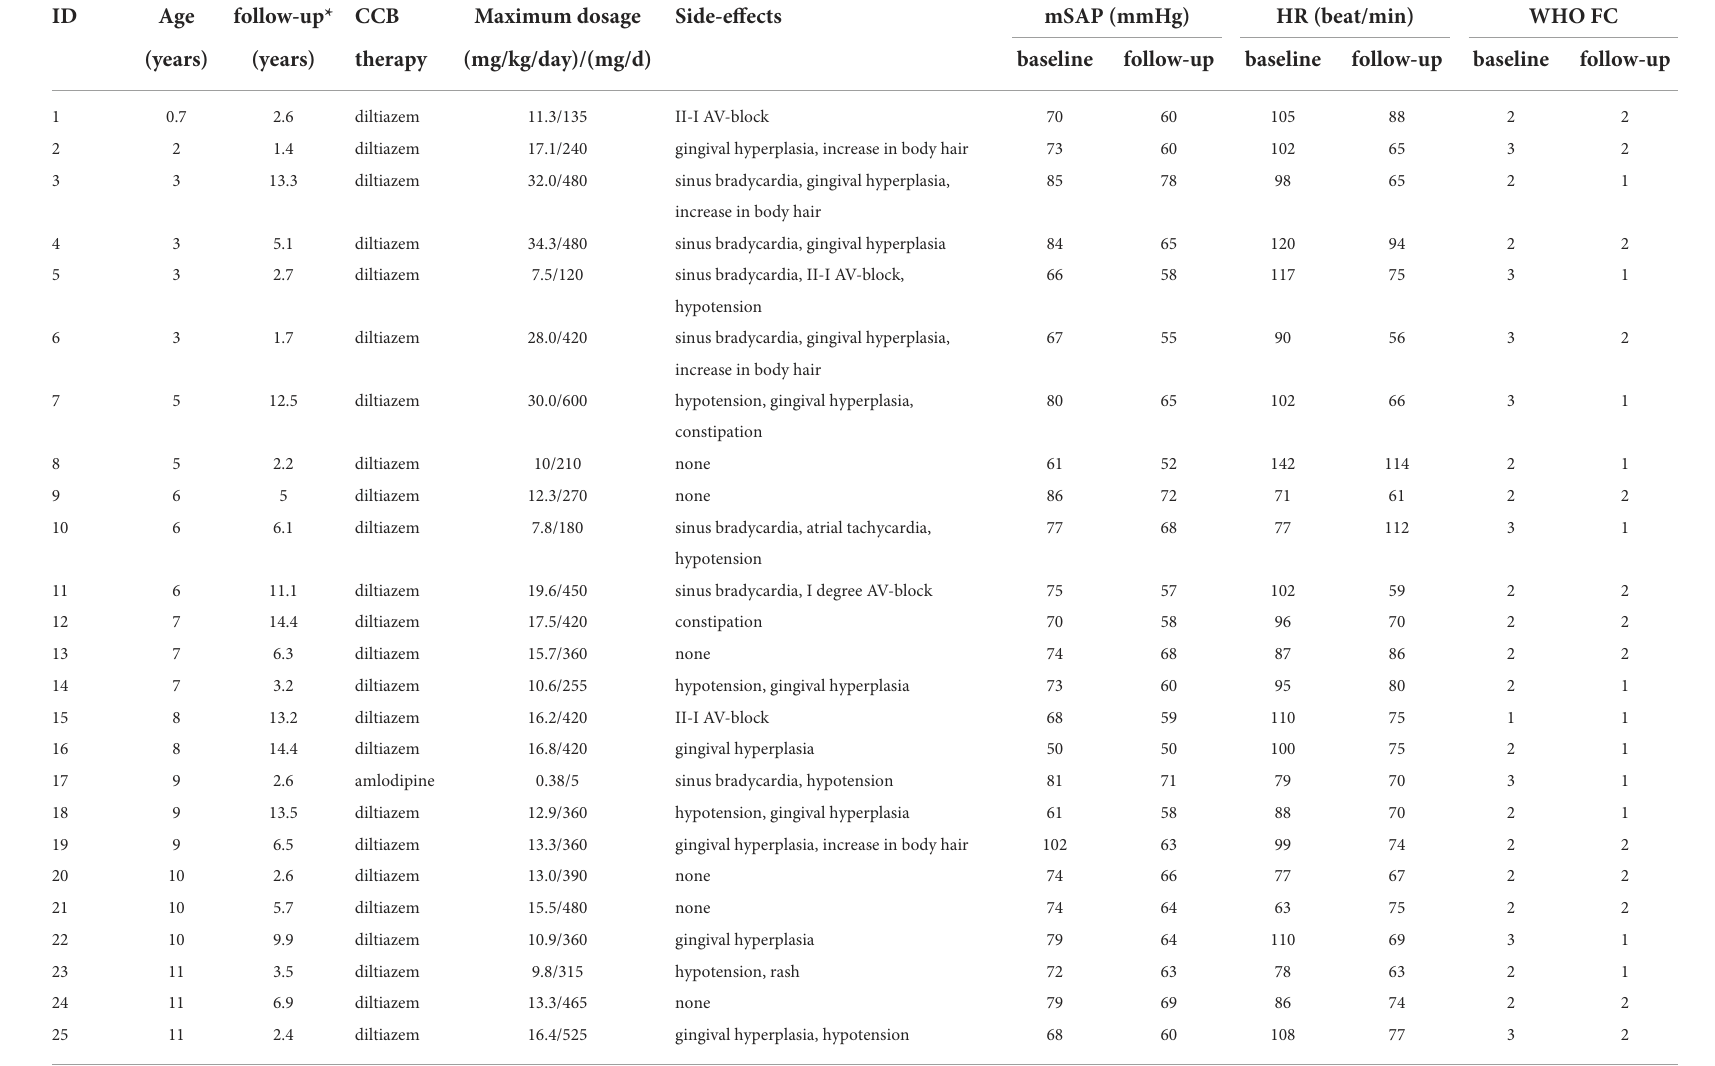
TABLE 2 Detailed clinical information of each